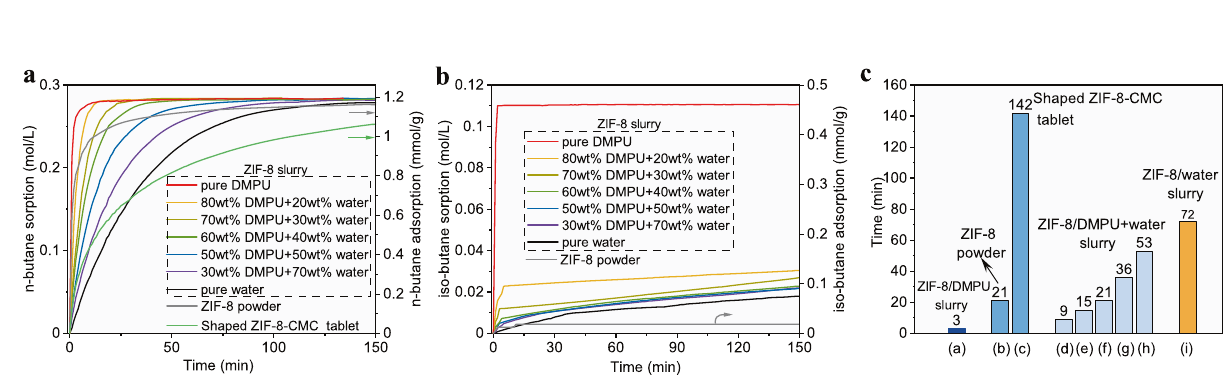
slurries were set to 293.15 K, ~6.8, ~26.7 and 30 wt% respectively. CMC: Carbox- ymethyl Cellulose Sodium; c comparison of time for different sorption media to reach90%oftheequilibriumsorptioncapacityofn-butane,where “ d ” to “ h ” onthe abscissa corresponds to 20 to 70wt% of the water content in the